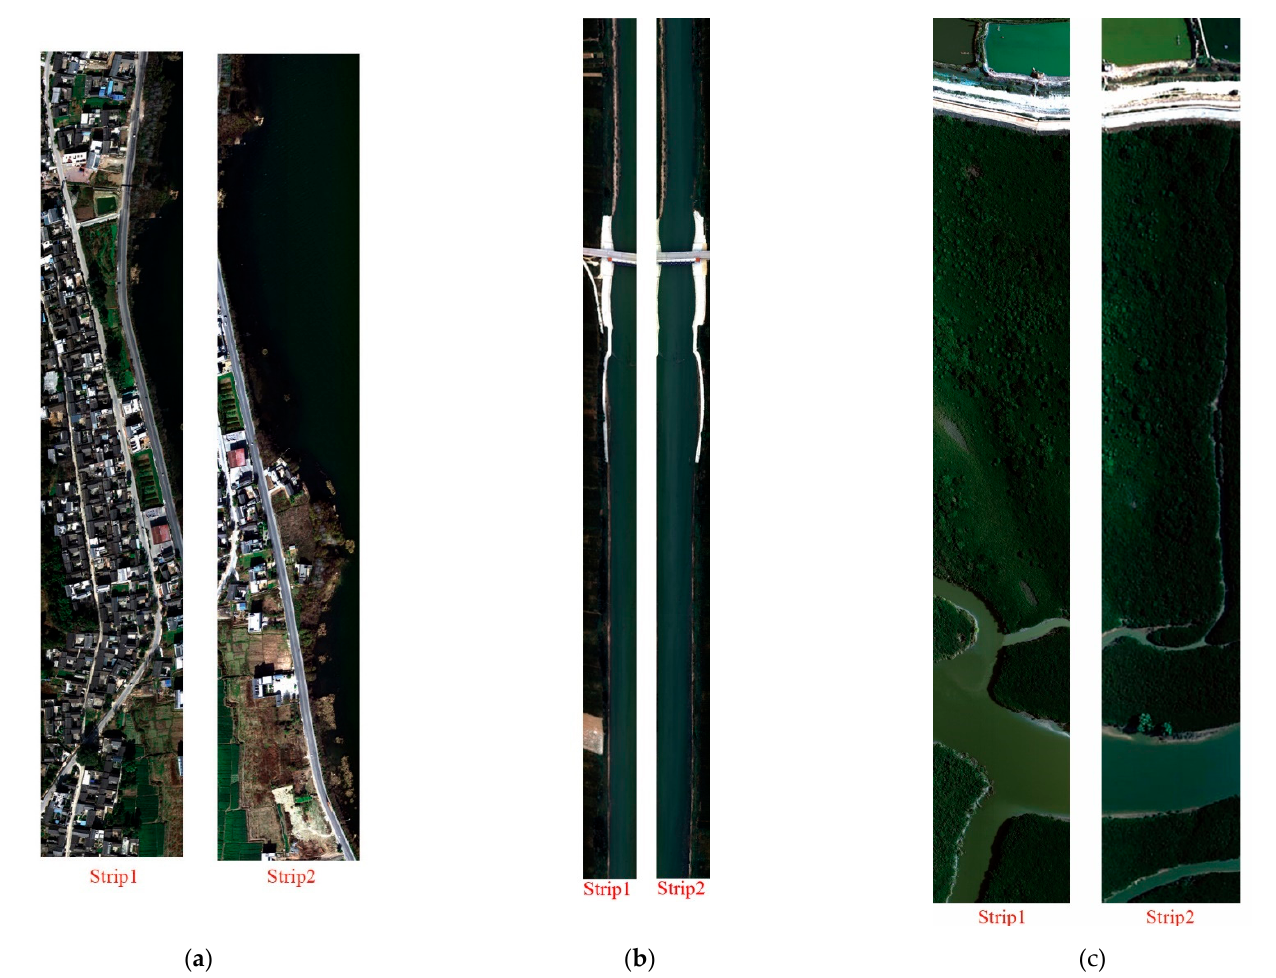
Figure 3. True color images of two neighboring image strips (bands of 103, 63 and 27): ( a ) Urban scape; ( b ) River course; ( c ) Forest.